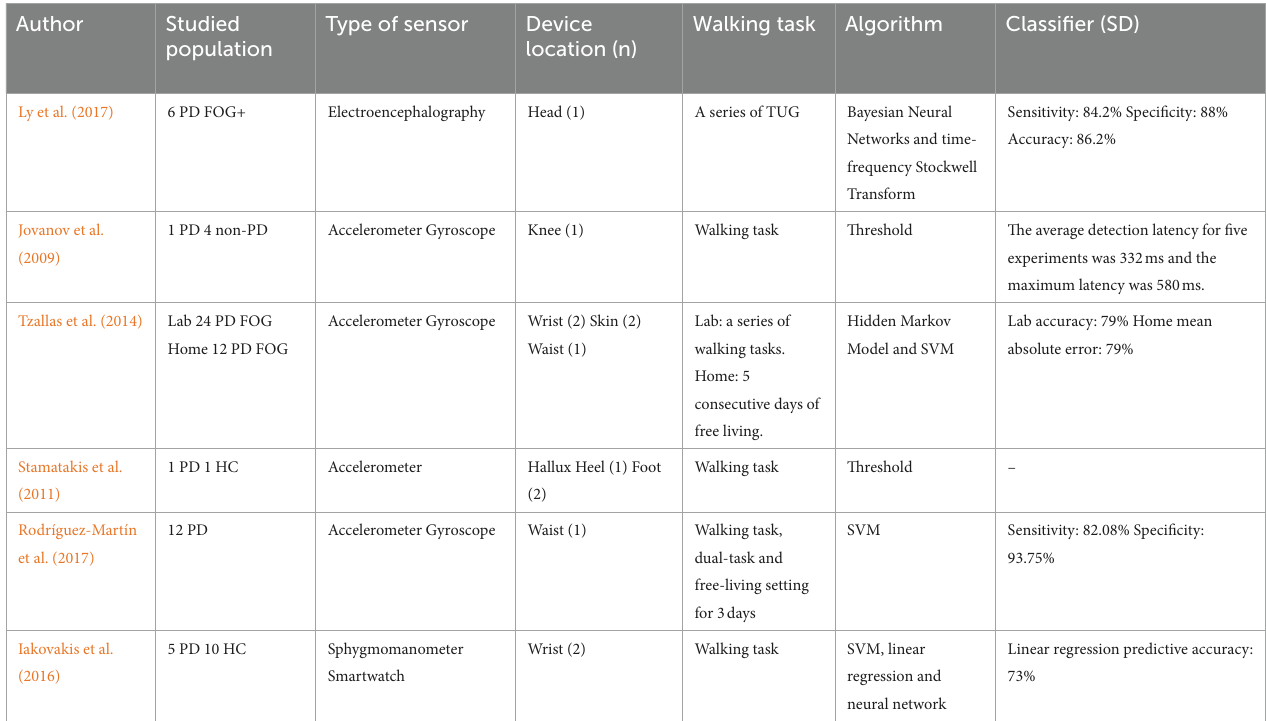
Linear regression predictive